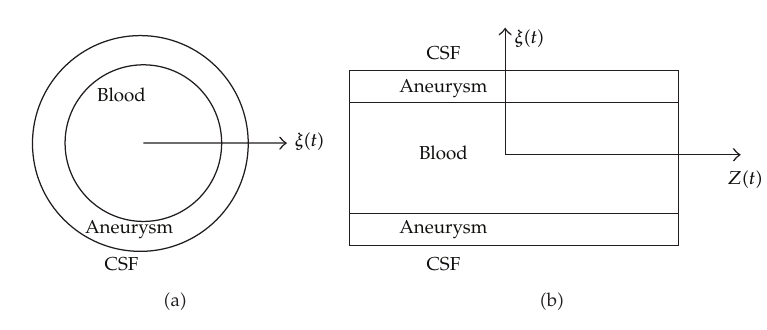
Figure 1: Membrane